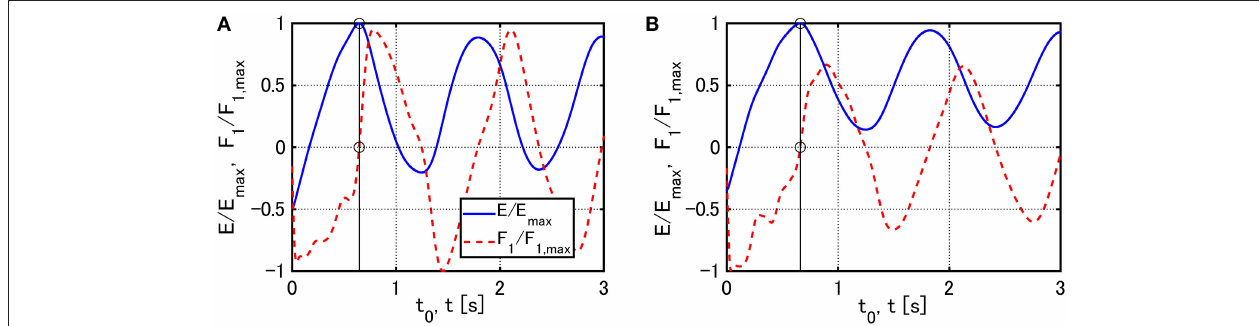
FIGURE 2 | Examples of the time history of F 1 = c 1 ˙ u 1 + f 1 for the model subjected to the first single impulse and the variation of the input energy E by the second impulse with respect to t 0 : (A) V = 0.84[m/s], (B) V = 1.23[m/s].